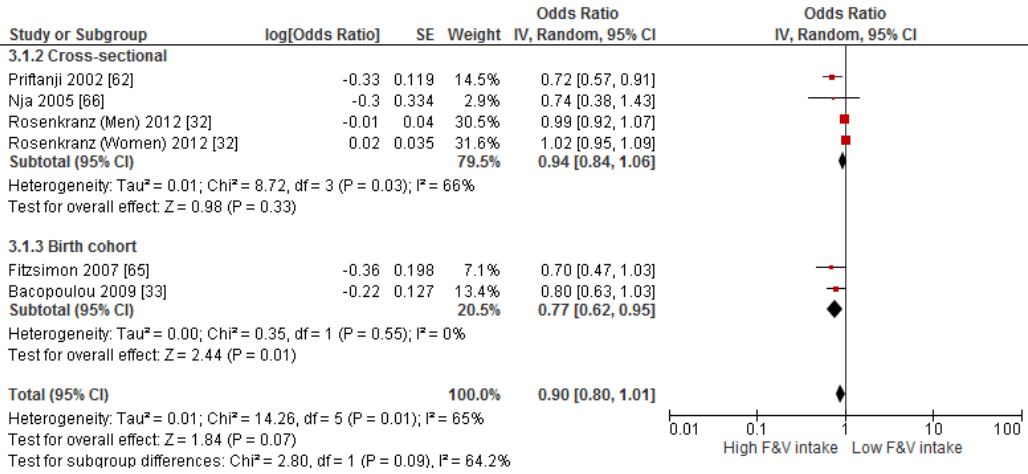
Figure 8. Meta ‐ analysis of the association between vegetable intake and risk of prevalent wheeze.